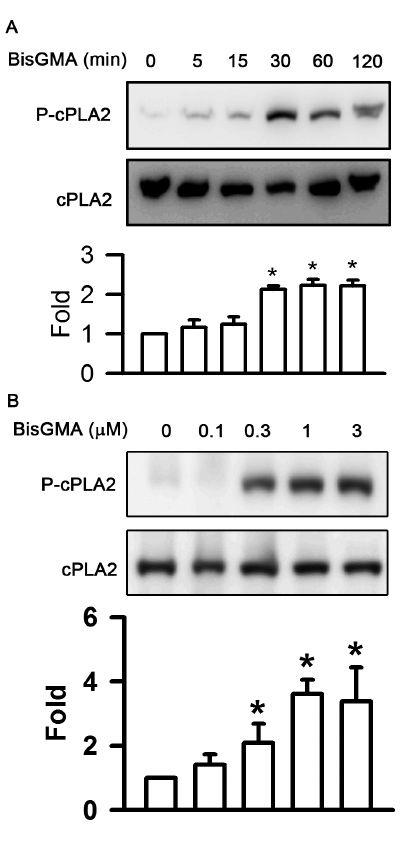
Figure 3. Effects of BisGMA on the phosphorylation of cPLA2. (A) Cells were stimulated with 3 m M BisGMA for the indicated treatment periods. (B) Cells were stimulated with the indicated concentrations of BisGMA for 2 h. Cells were harvested and protein extracts were subjected to SDS-PAGE. Western blot analysis using antibodies against phosphorylated and total cPLA2. The ratio of immunointensity between the phosphorylation and total protein was calculated. Values are expressed as mean 6 SD (n=3). *represents significant difference from control values with p , 0.05.